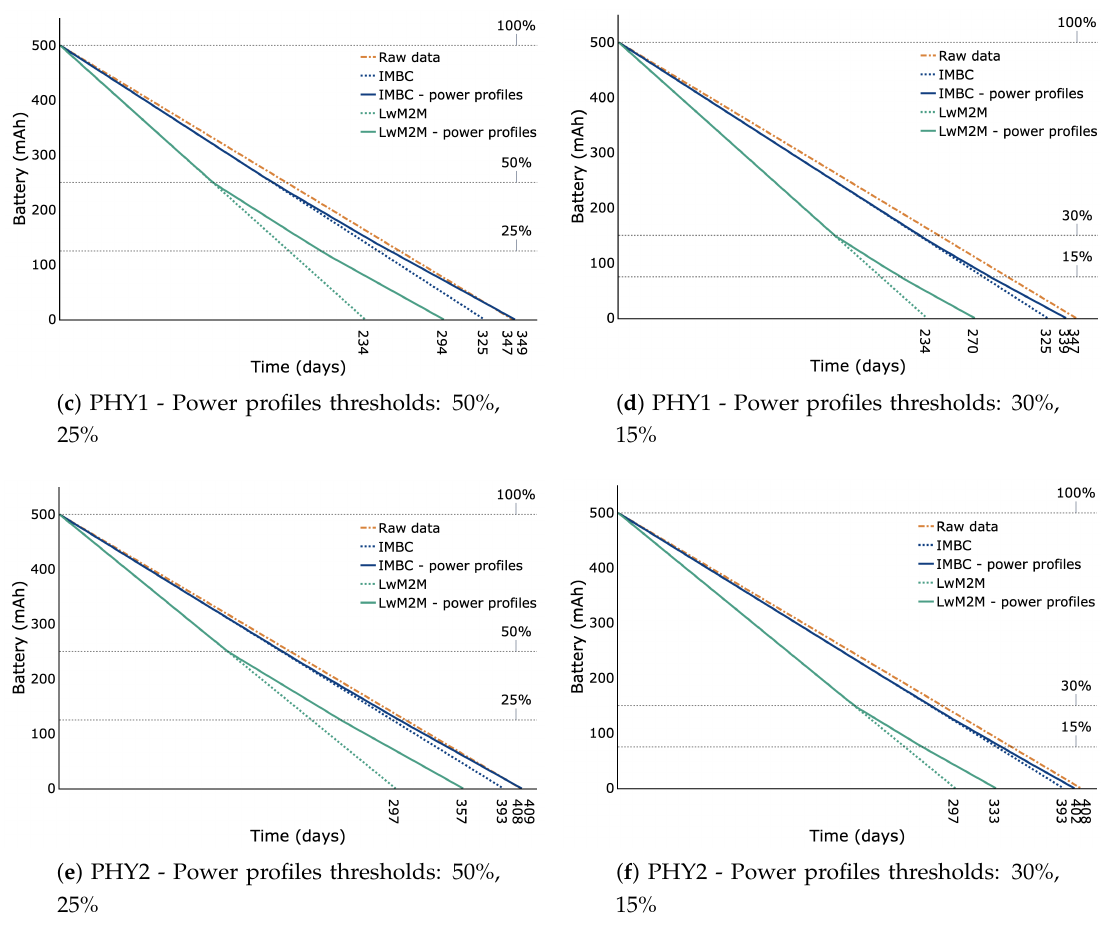
Figure 6. Battery lifetime for Bluetooth data rates PHY8S, PHY1 and PHY2 when transmitting Raw data, IMBC data, IMBC data with power profiles, LwM2M TLV data and LwM2M TLV data with power profiles. The orange coloured lines correspond to Raw data, the blue coloured lines correspond to IMBC data and the green coloured lines correspond to LwM2M